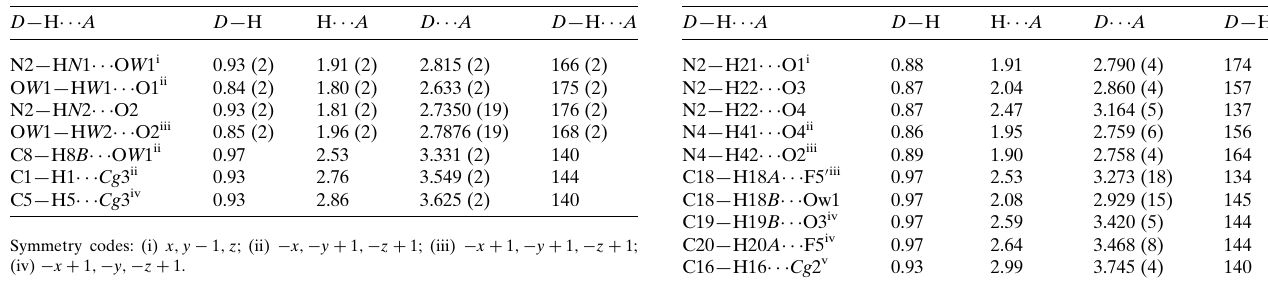
Table 4 Hydrogen-bond geometry (A˚ , (cid:3) ) for ( IV ). Cg 2 is the centroid of the C1–C6 phenyl ring.